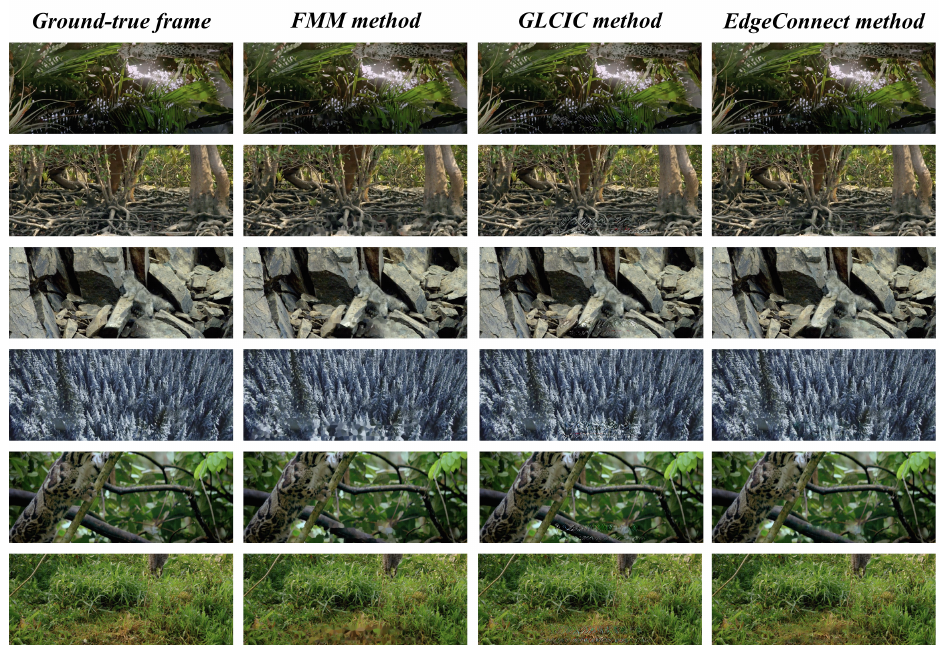
Figure 6. Comparison of the original frames and the inpainting results of other existing methods as well as our method.